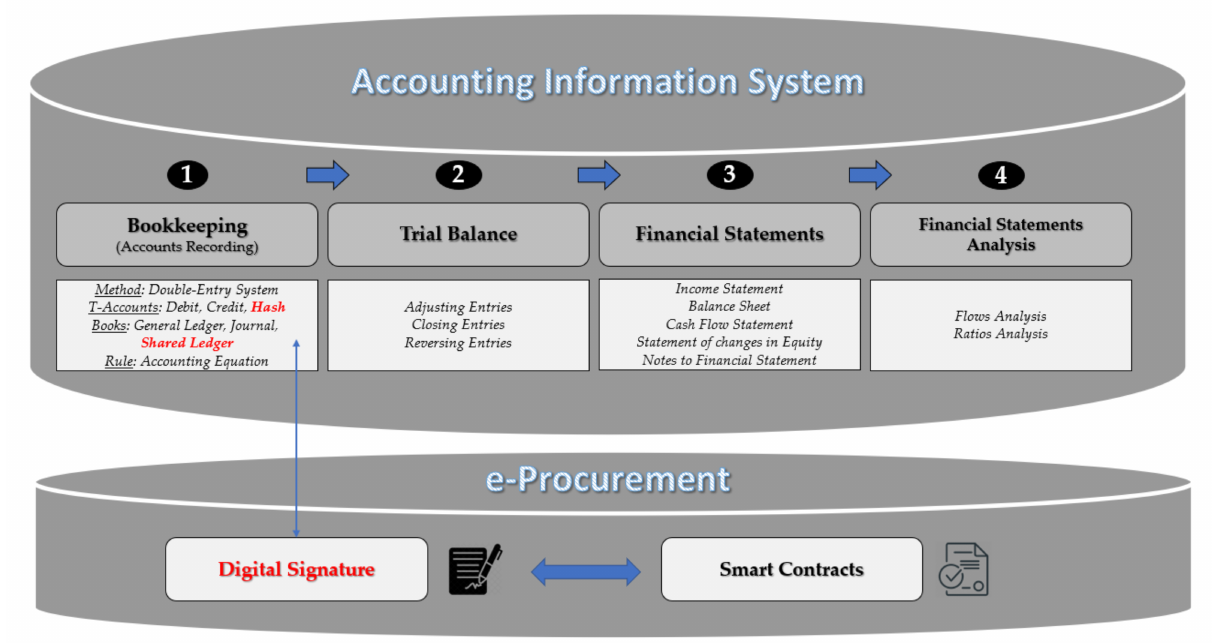
Figure 4. AIS and e-Procurement Processes